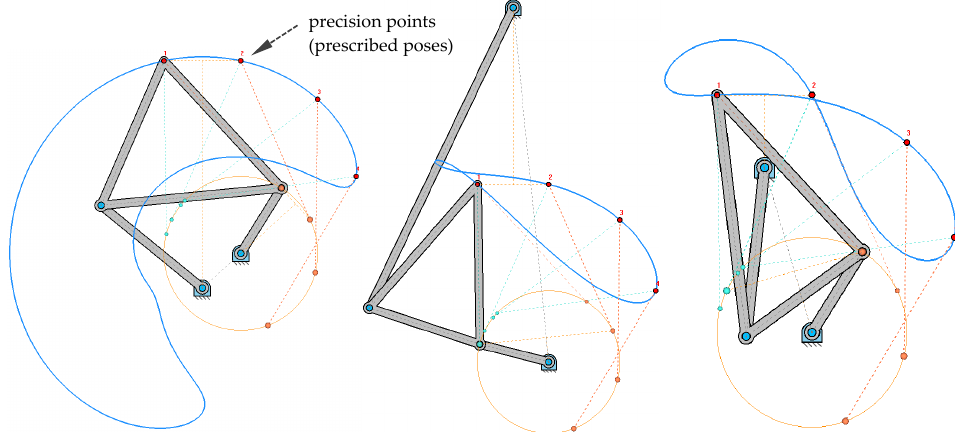
Figure 17. Path planning synthesis; multiple solutions.